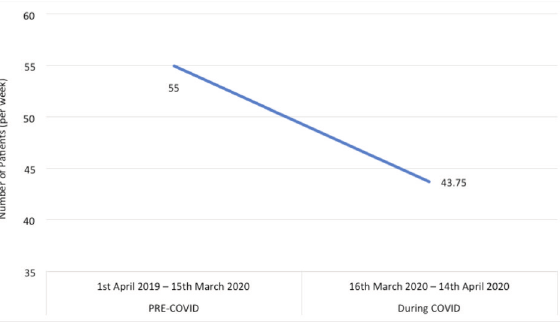
Average referrals from Accident and Emergency to Fig. 3: trauma and orthopaedics (per week).